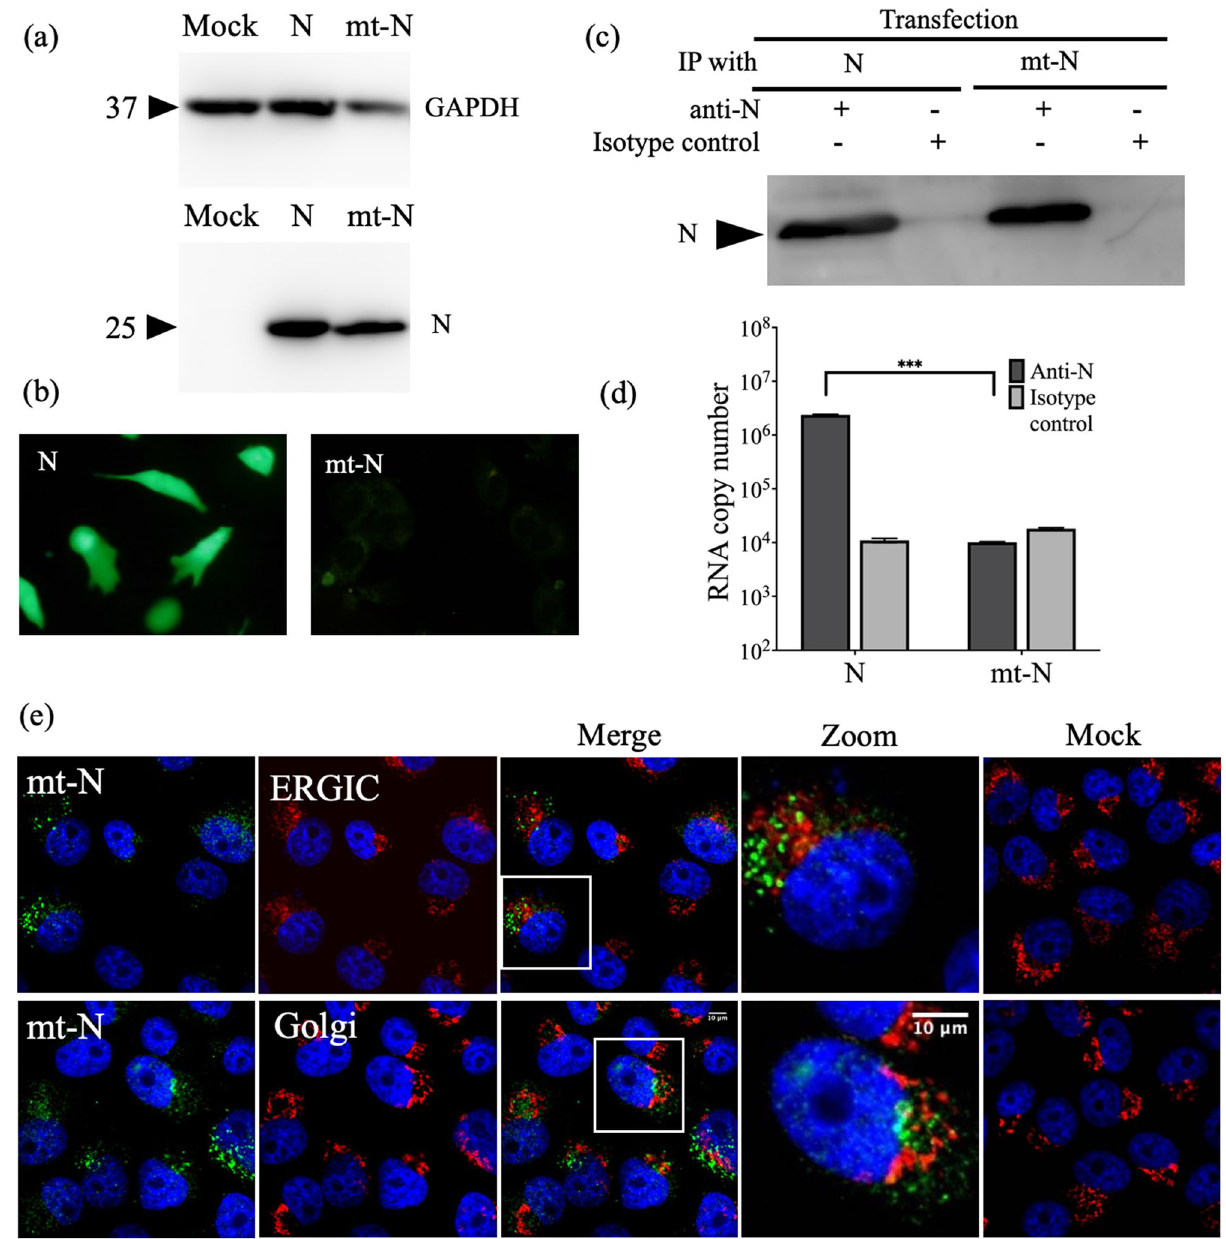
Figure 3. Functional analysis of N and mt-N proteins of SFTSV. (a) The cell lysate of mt-N protein-transfected 293 T cells was used for western blot analysis, and expressed proteins were determined using anti-rabbit N polyclonal antibody as the primary antibody and HRP-conjugated Protein A as the secondary antibody. GAPDH was used as a control. (b) BSR-T7/5 cells were transfected with pCAGGS-SFTSV N (left panel) or pCAGGS-SFTSV mt-N (Right panel) together with pCAGGS-SFTSV L and pATX-vRNA-eGFP and eGFP expression was examined. (c) Cell lysates from (b) were immunoprecipitated with anti-N. Both N and mt-N proteins successfully bound to the beads and were detected by western blotting using rabbit anti-N pAb. (d) Minigenome RNA was detected from immunoprecipitated fraction by qPCR of eGFP gene (corresponding to * P < 0.05, ** P < 0.01, and *** P < 0.001). (e) Subcellular localization of the mt-N protein in Vero cells. Plasmids pCAGGS-SFTSV-mt-N, pCAGGS-SFTSV-RdRp, pCAGGS-SFTSV-GP, and vRNA-Rluc were transfected, and the luciferase activity was not detected in these cells (Supplementary Fig. 5). The cells were stained with antibodies against N protein (green) and ERGIC or Golgi organelle markers (red), and the nuclei were stained with DAPI (blue). Magnification of the merged area is shown on the right side of the merged image. The mock-transfected cells are shown as mock images. (f) Sub-cellular localization of HA-tagged N and HA-tagged mt-N proteins in SFTSV- infected BHK/T7-9 cells. SFTSV-infected BHK/T7-9 cells were transfected with pCAGGS-SFTSV-N or pCAGGS-SFTSV mt-N. SFTSV infection rate was around 90% confirmed by staining with anti GP pAb. The cells were stained with antibodies against HA-tag protein (green) and ERGIC or Golgi organelle markers (red), and the nuclei were stained with DAPI (blue). The mock-infected and transfected cells are shown as SFTSV ( −). (f) Co-localization analysis of HA-tagged N and mt-N proteins with Golgi apparatus markers shown in (f) using Fiji/ImageJ (***corresponds to a P value of < 0.001). Number of cells =